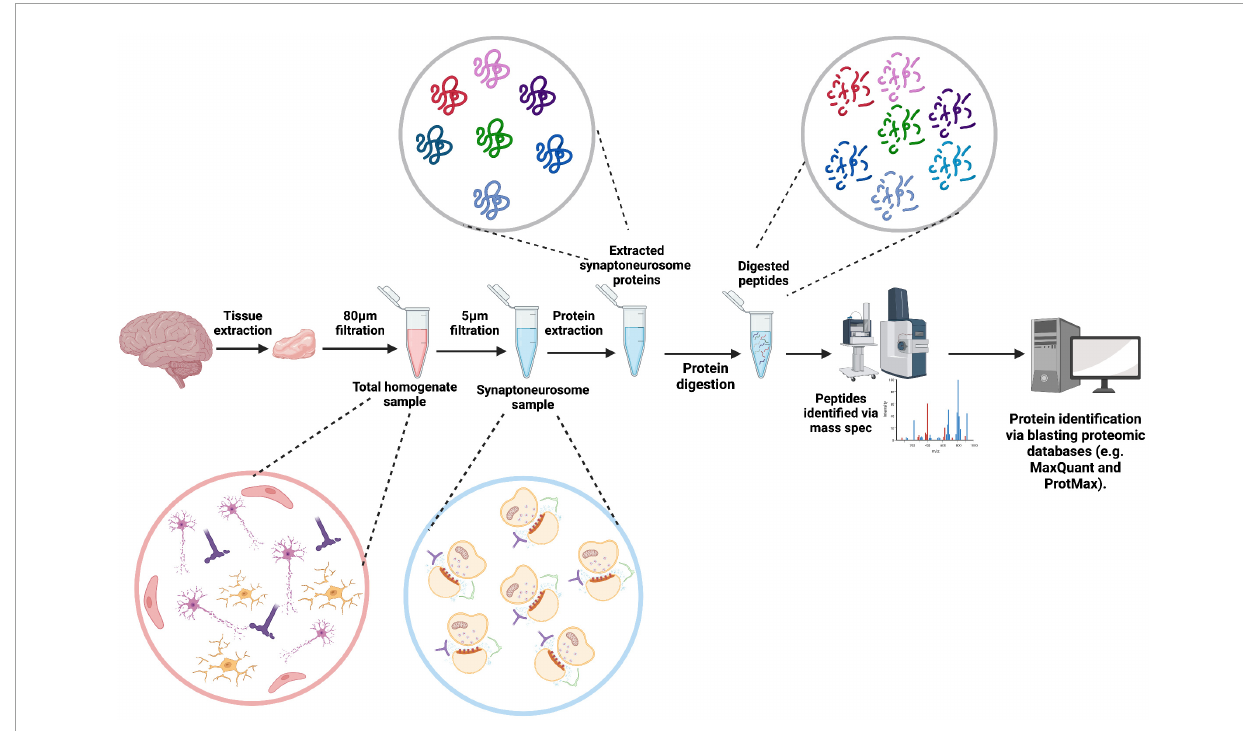
FIGURE3 Synaptoneurosome proteomics workflow. A tissue sample is extracted from post-mortem brain tissue, homogenized in homogenization buffer breaking apart the tissue. The sample is then pushed through an 80 µ m filter, removing any tissue components, leaving a total homogenate sample containing fragmented cellular components. Further filtration through a 5 µ m filter removes all nuclear components of the sample, leaving synaptoneurosomes. Synaptoneurosome proteins are then accessed through protein extraction with a lysis buffer and digested into peptides. The peptides are inputted into the mass spectrometer and identified peptides are blasted against proteomic databases to identify the corresponding proteins. Created with